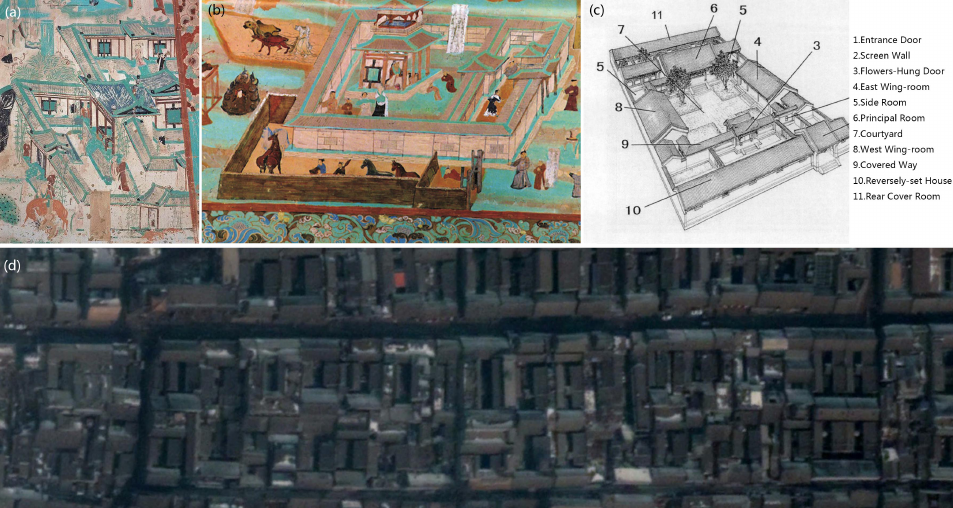
Figure 6. ( a ) Frescoes from Kiln 9 at Dunhuang; ( b ) frescoes from Kiln 85 at Dunhuang; ( c ) A typical three-story courtyard in Beijing [62]; ( d ) An overhead view of the ancient city of